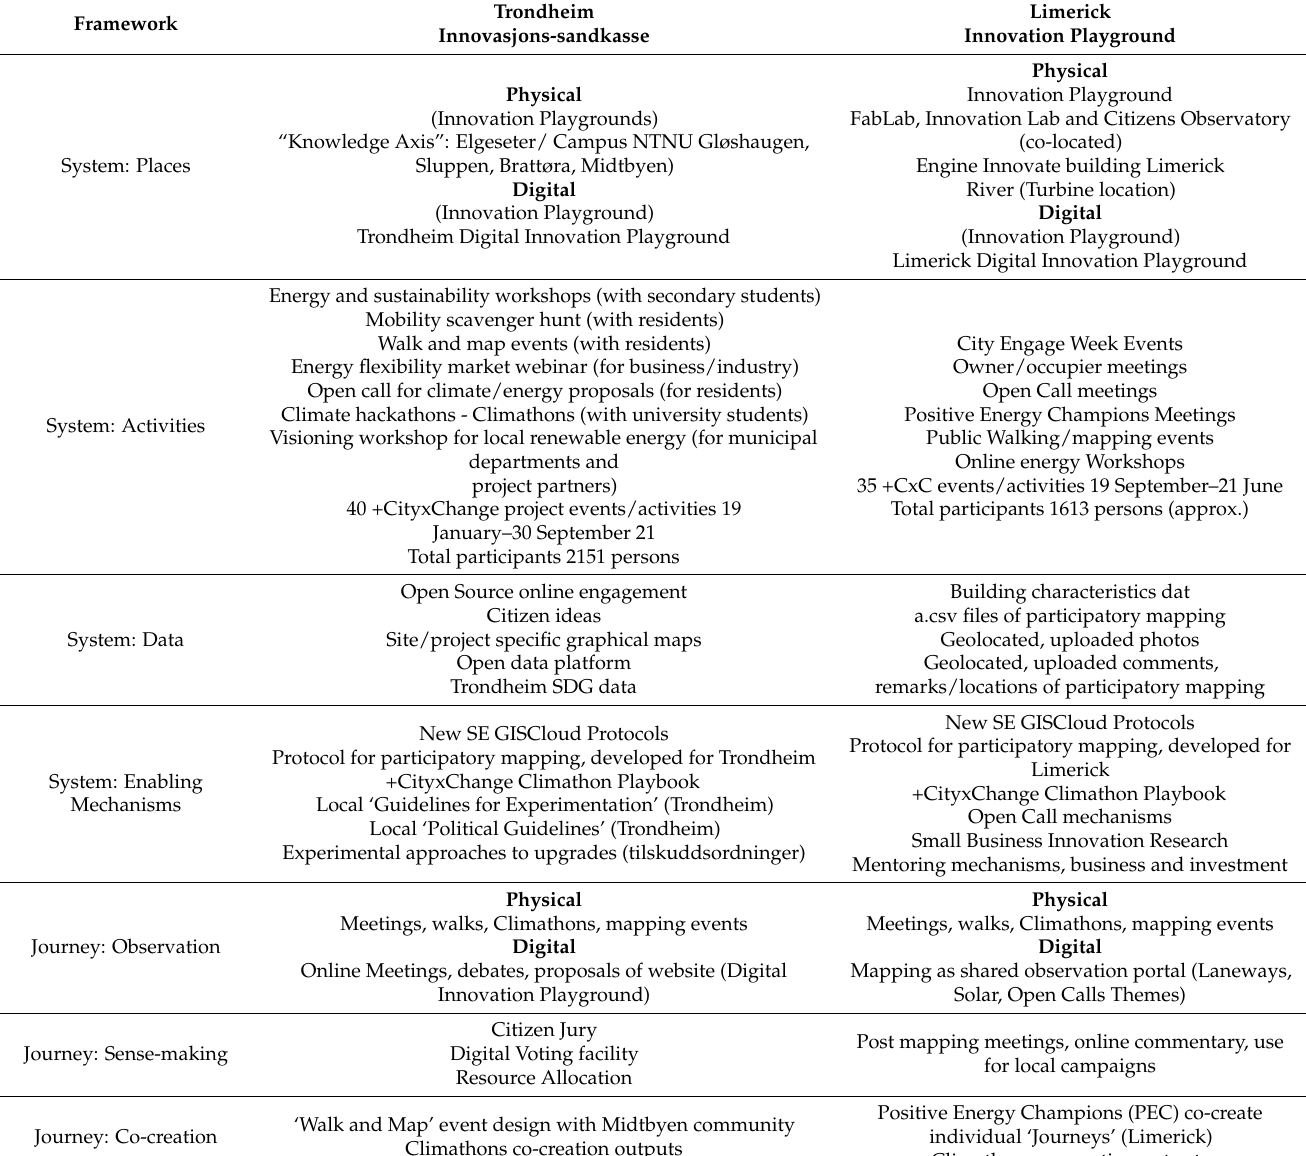
Table 1. Table of Implementation of Innovation